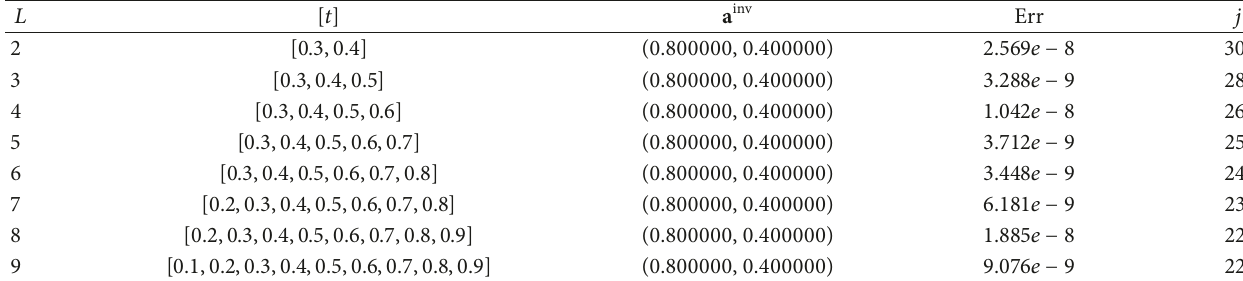
Table 2: The inversion results with number of the additional data for 𝑆 = 1 .